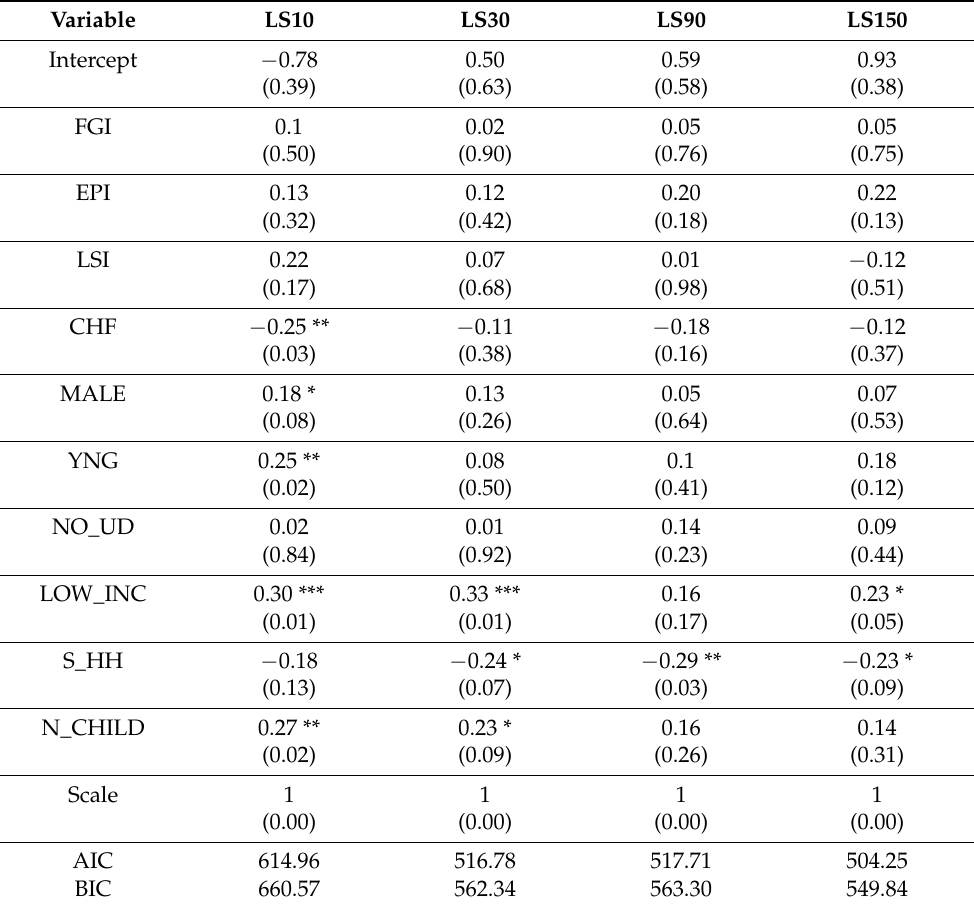
Table 4. Parameter estimates, standard errors (in parentheses) and goodness-of-fit statistics for